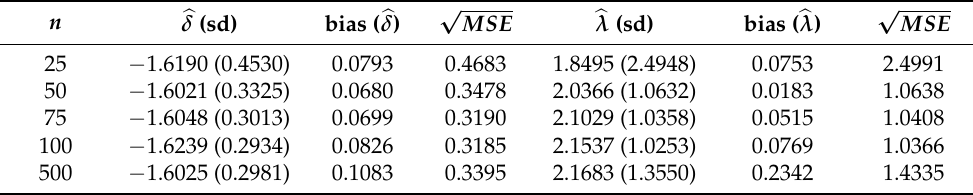
Table 7. Simulations for (cid:98) δ and (cid:98) λ